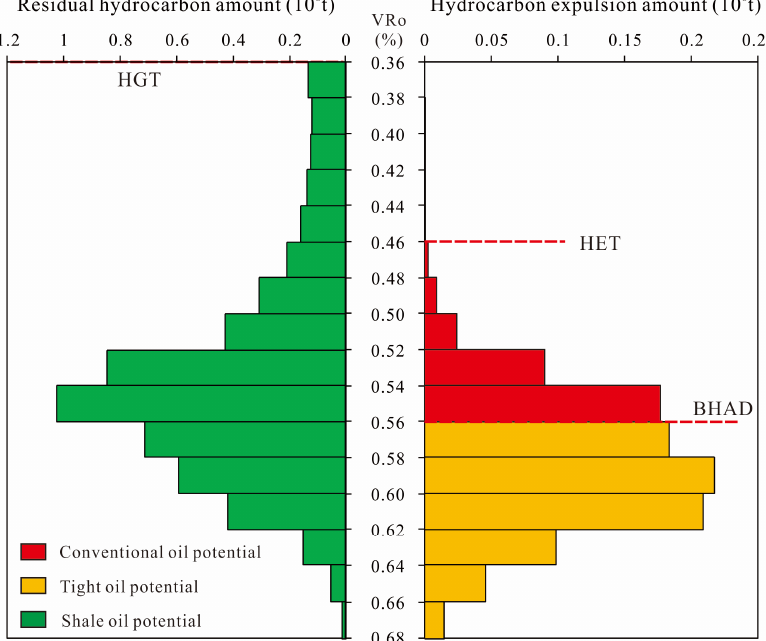
Figure 18. Conventional, unconventional tight, and shale oil resource potentials of the Es4n source rocks in the Niuxintuo area.